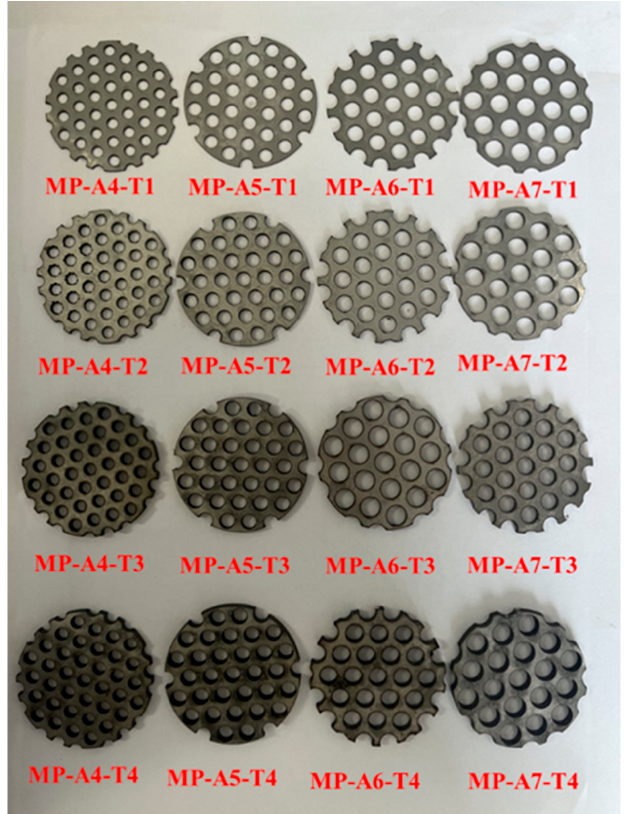
Figure 2. Types of wave-absorbing metal plates.